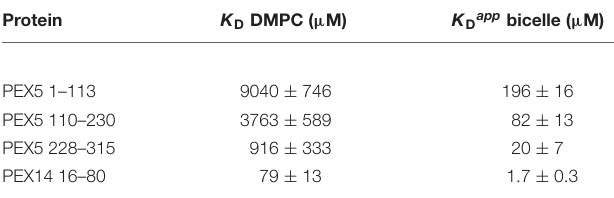
TABLE 1 | NMR-derived membrane binding affinities.